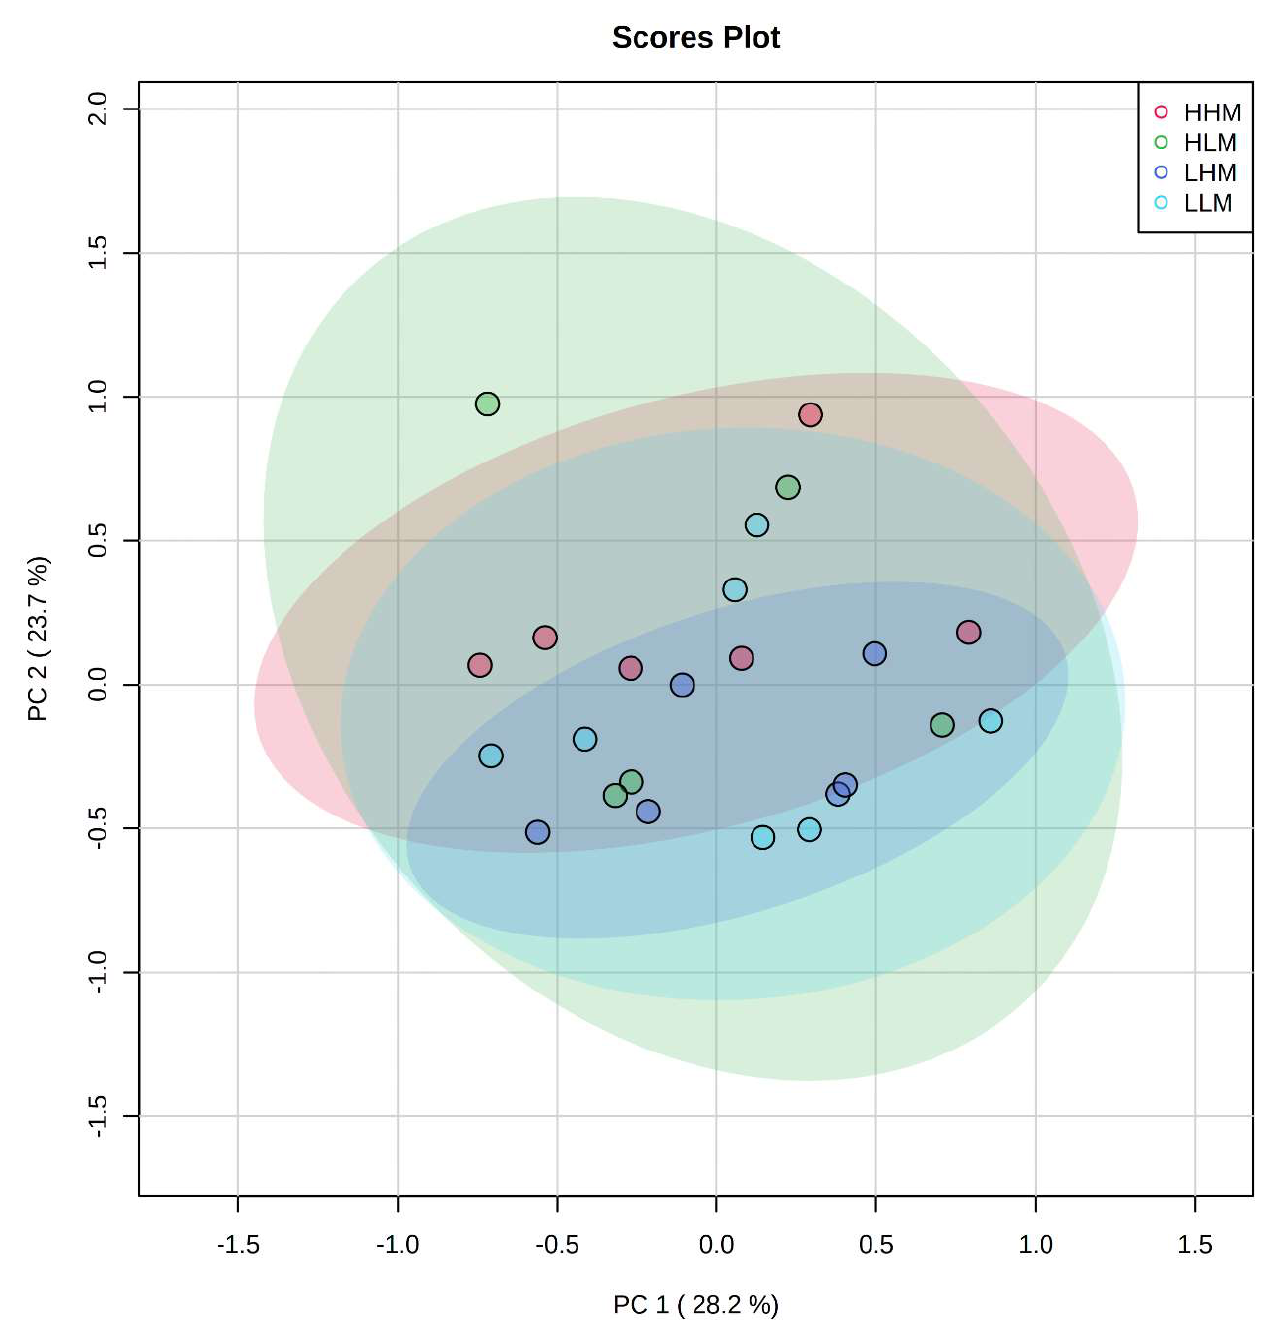
Figure 2. PCA of male offspring, indicating a lack of clustering between offspring exposed to high maternal and high postnatal LA diets in males (HHM: Red), high maternal and low postnatal LA diets in males (HLM: green), low maternal and high postnatal LA diets in males (LHM: dark blue), and low maternal and low postnatal LA diets in males (LLM: light blue). All metabolites have been scaled logarithmically. Illustrates variance (%) in PC1 and PC2.